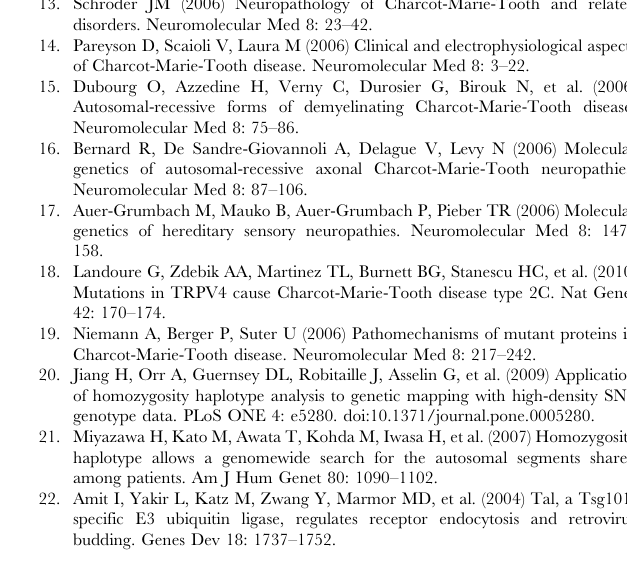
Table S2 LRSAM1 PCR primers and conditions. 95C for 2 min. Followed by 25 cycles of 95C for 30 sec, the appropriate annealing temperature (listed in table above) for 30 sec, and 72C for 1 min. Finish with 72C for 5